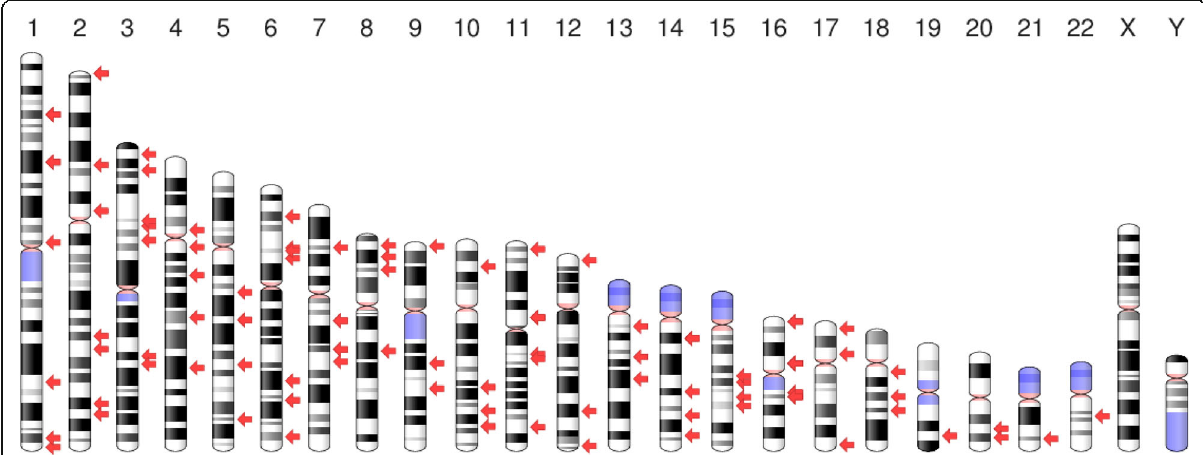
Fig. 1 Chromosomal ideogram of human obesity susceptibility genes. The chromosomal loci for 127 obesity susceptibility genes are provided using a chromosomal ideogram and denoted by red